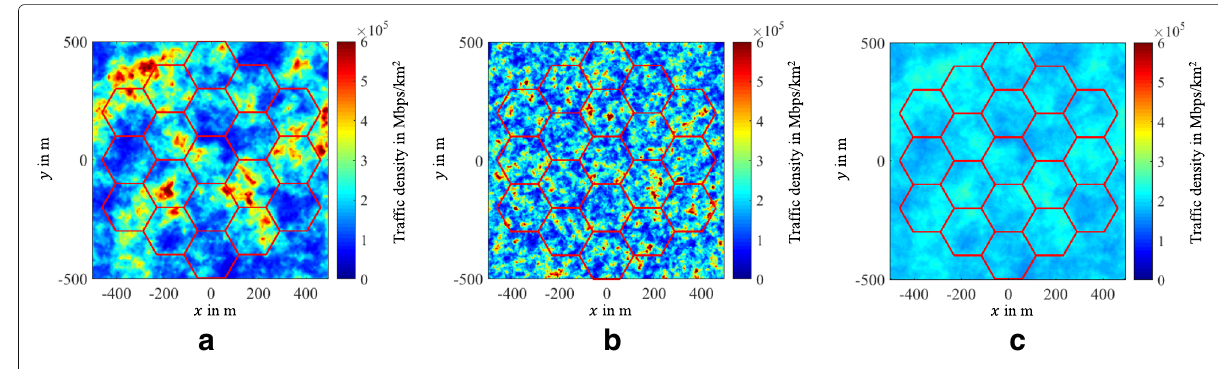
Fig. 5 Exemplary traffic distributions. b Lower correlation distance and c Lower standard deviation compared to a